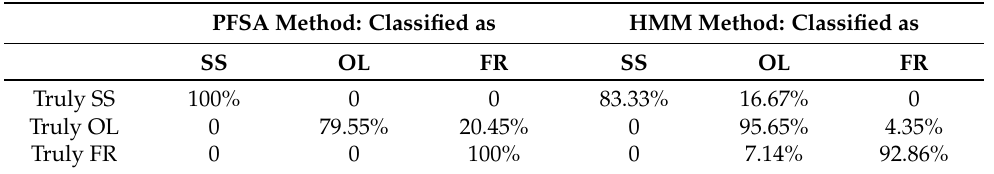
Table 3. Confusion matrix showing the classification accuracy of the regimes from the dataset with no radiation heat loss using the optimally trained PFSA and